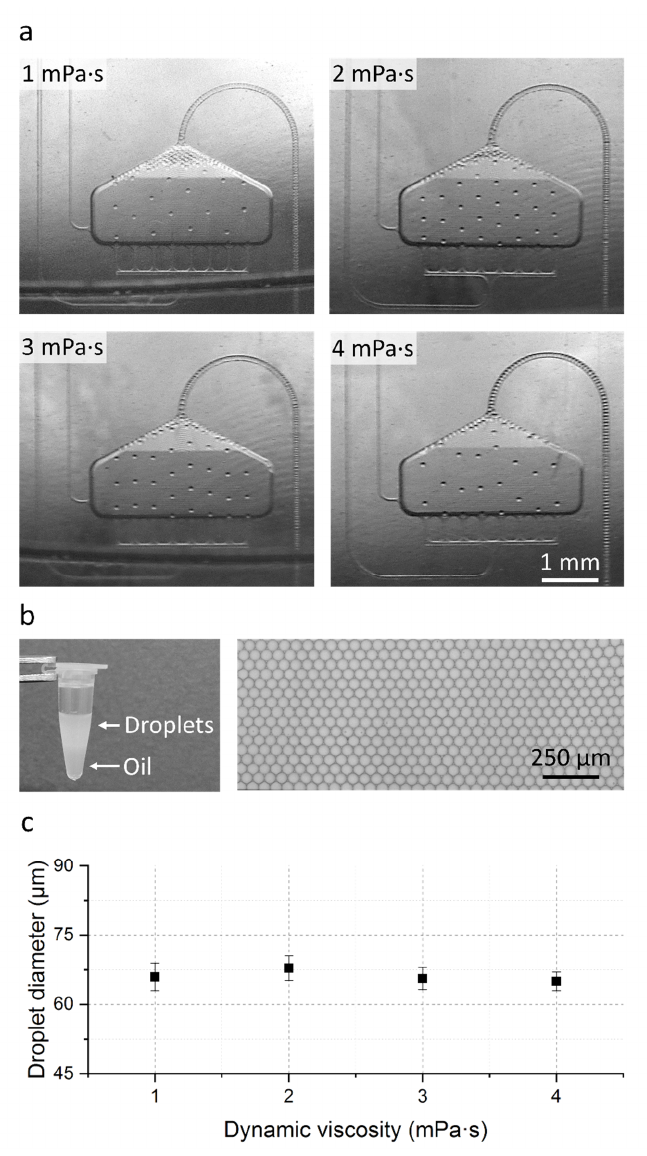
Figure 2. Results of the fluidic evaluation. ( a ) Stroboscopic images of the droplet generation and transfer process for all tested viscosity cases. ( b ) Picture of the generated emulsion in a tube (left); Microscopic image of the generated droplets in a droplet monolayer after transfer to a counting chamber (right, cropped image section of a representative picture). ( c ) Measured droplet diameter in relation to the sample viscosity for all tested viscosity cases. For each viscosity case, two cartridges were analyzed. Droplet diameter was measured with an automated ImageJ script ( n = 1000, for details see ESI 2, S2). Error bars represent the standard deviation.